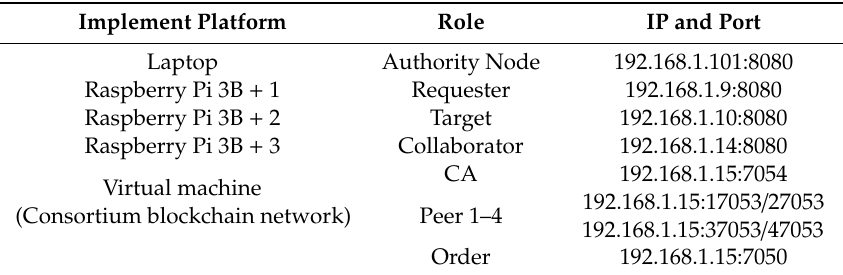
Table 1. The network configurations of our experiment.